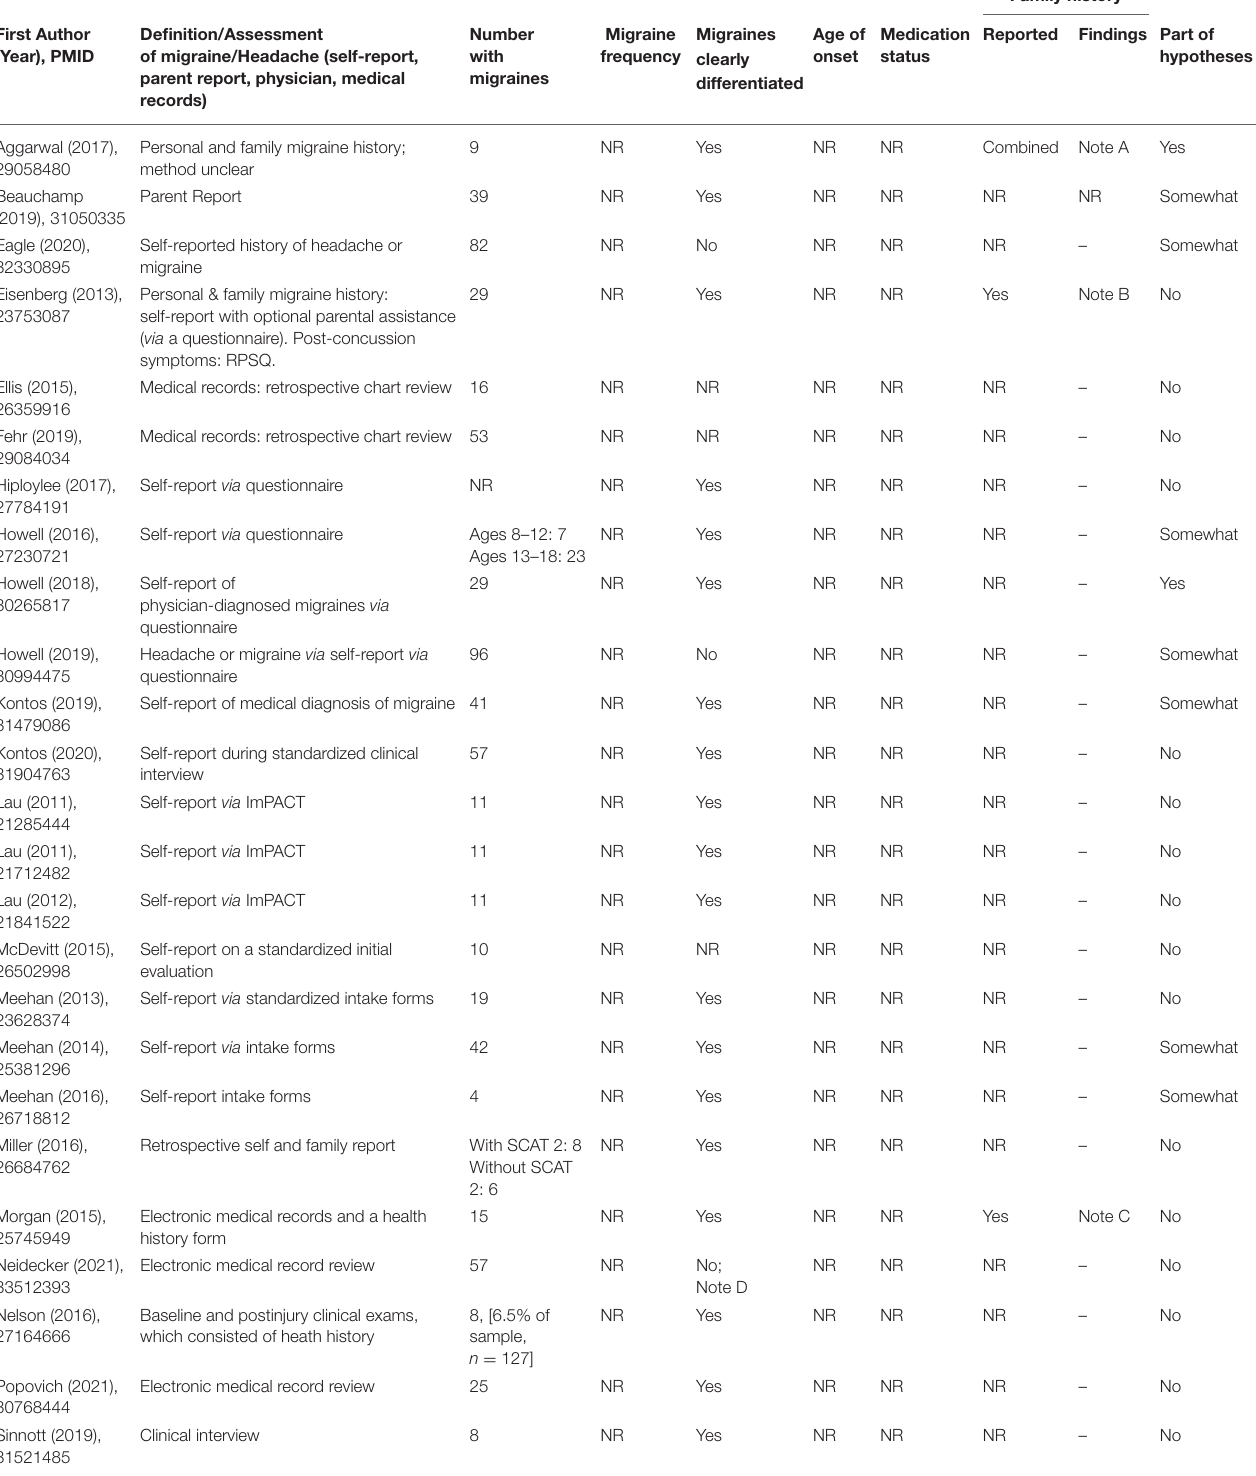
TABLE 2 | Methodological review related to pre-injury migraines and concussion